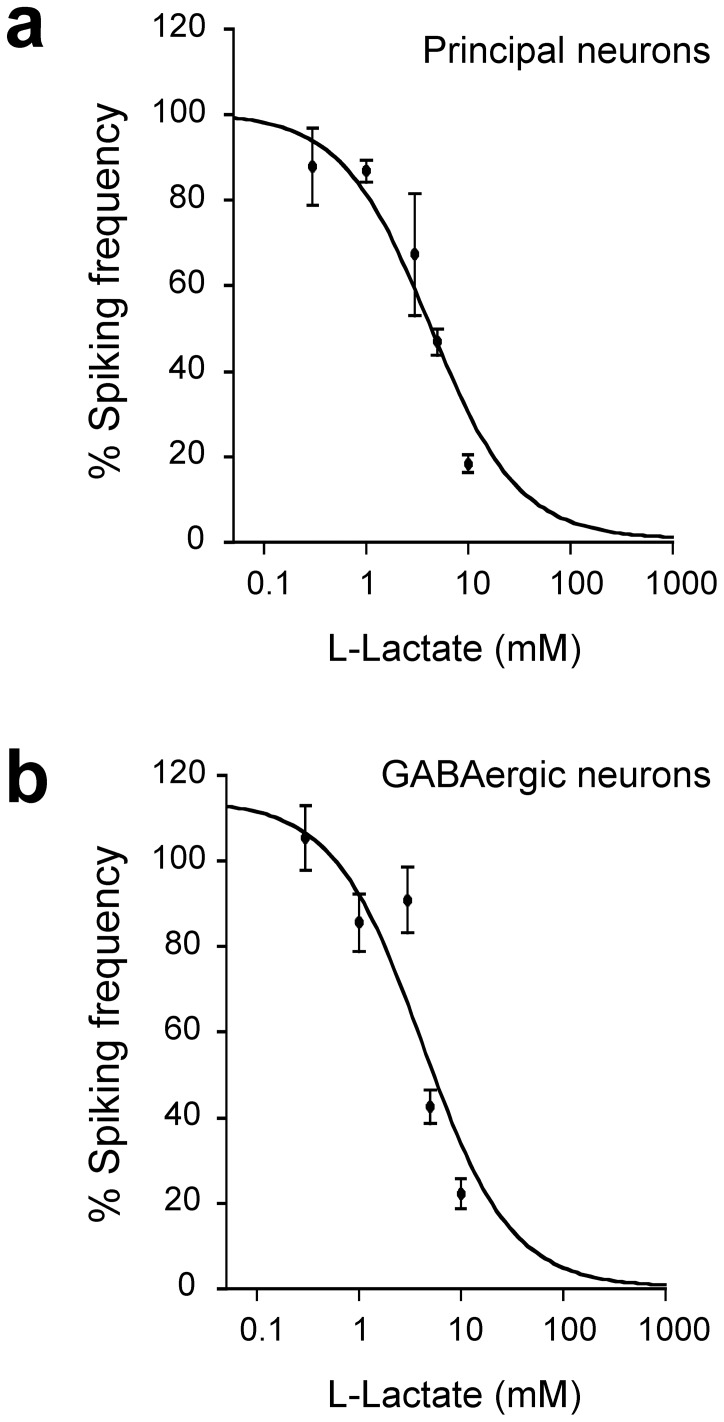
Concentration dependency of L-lactate effects.The decrease in calcium spiking frequency was concentration dependent. Apparent IC50 values obtained by nonlinear curve fitting yielded 4.2±1.9 mM for principal neurons (n = 175 cells, 56 exp) and 4.2±2.8 mM for GABAergic neurons (n = 83 cells, 35 exp).